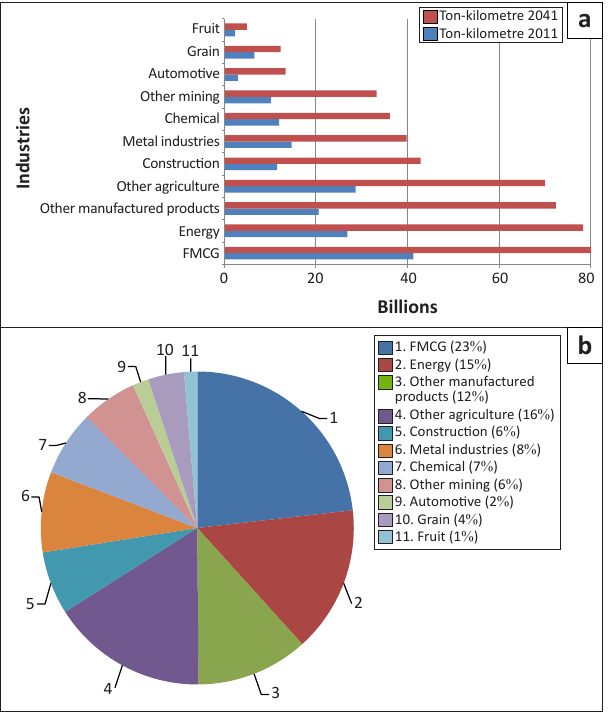
FIGURE 4: Growth in industry ton-kilometre demand 2011–2041 (a) 2011 vs 2041 and (b) 2011 only.